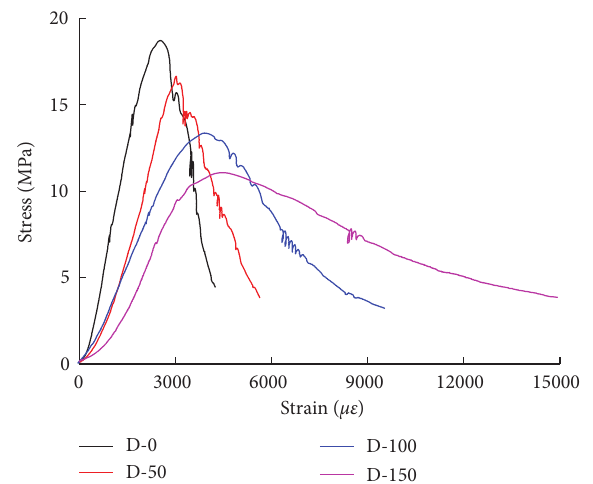
Figure 4: The compressive stress-strain curve of ordinary concrete under static loading strain